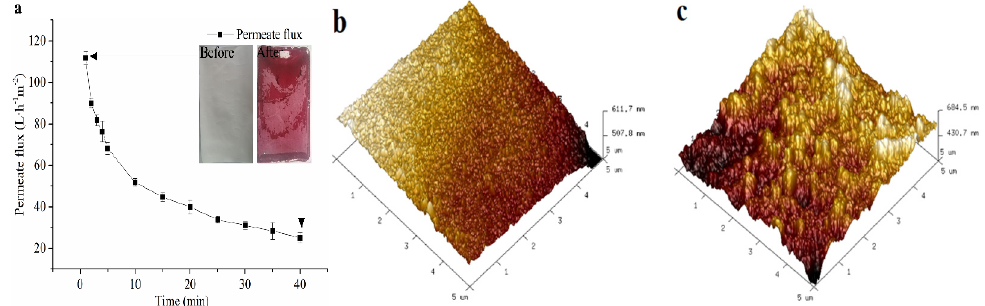
Figure 2. Changes of flux and membrane morphology during NF of blueberry extracts. ( a ) permeate flux; ( b ) pristine membrane; ( c ) fouled membrane.